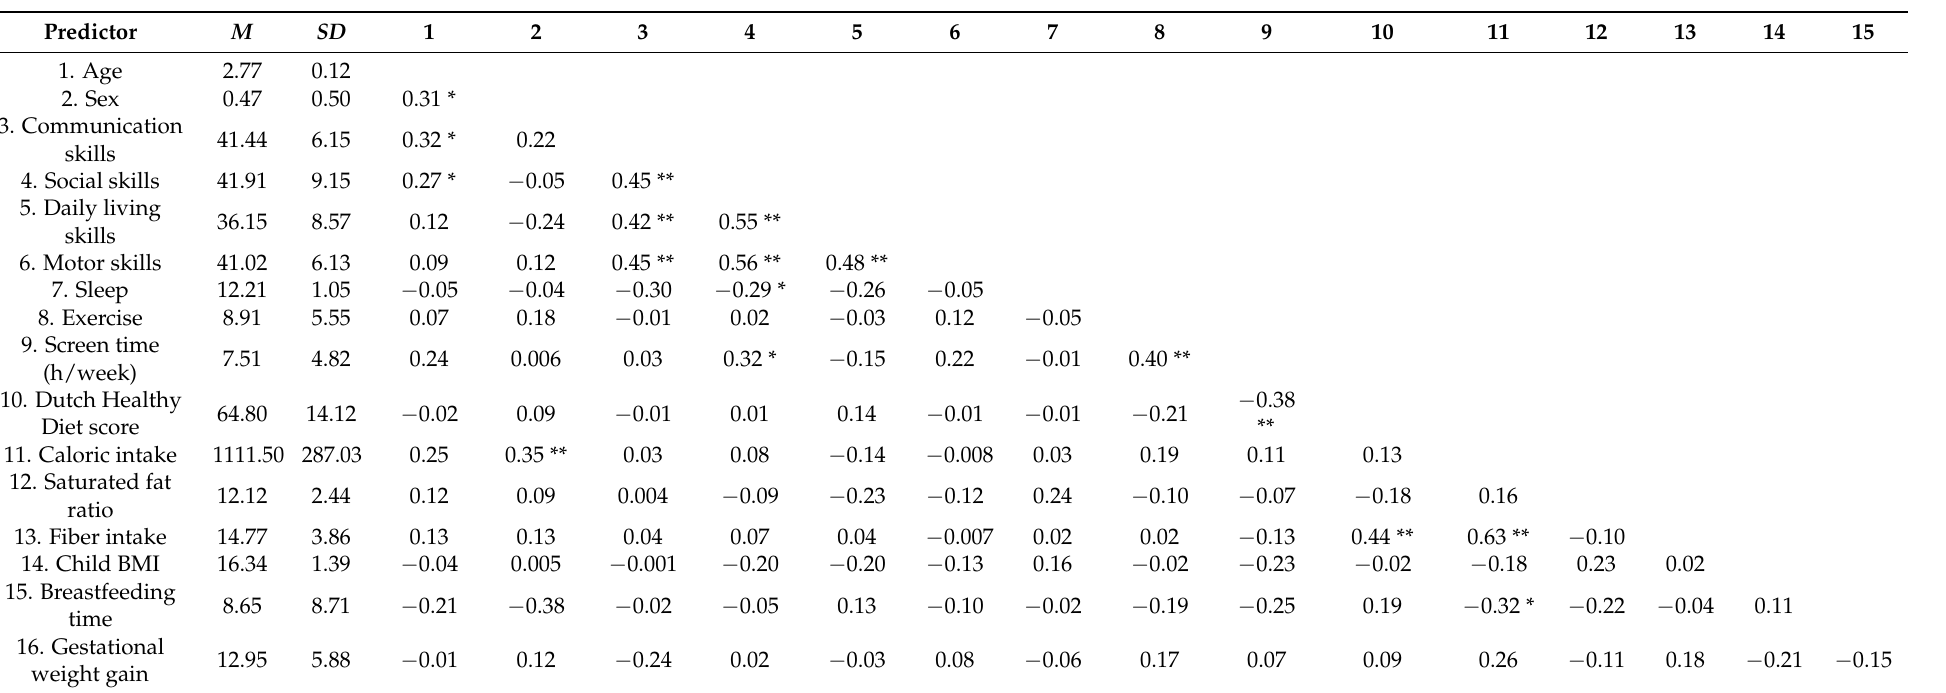
Table 1. Means, standard deviations, and Pearson’s correlations of the variables included in the exploratory regression analysis to investigate individual differences in task